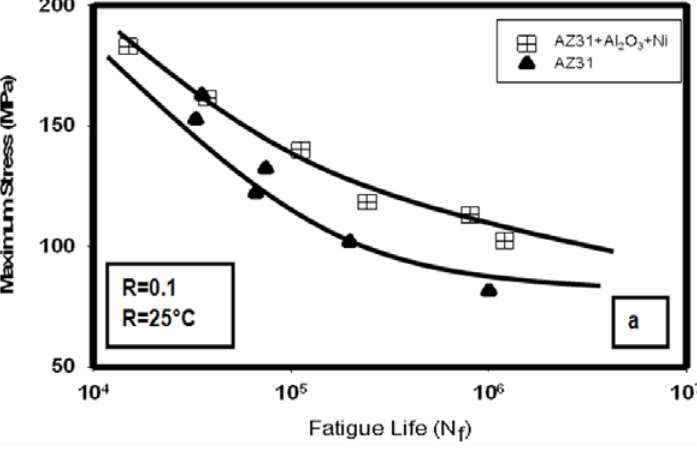
Figure 3. Comparison of the variation of maximum stress with fatigue life (N particle reinforced magnesium alloy (AZ31 + Al alloy (AZ31) cyclically deformed at room temperature (T = 25 °C) at: ( a ) Load ratio of 0.1 and ( b ) Load ratio of −